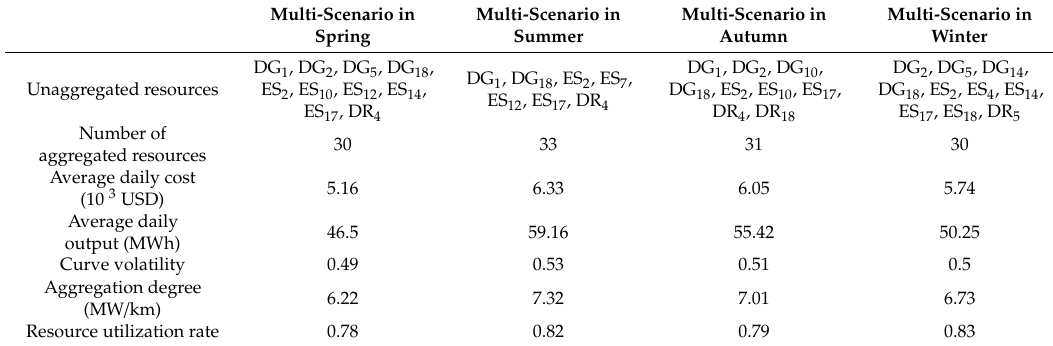
Table 5. Resource aggregation results in each season.